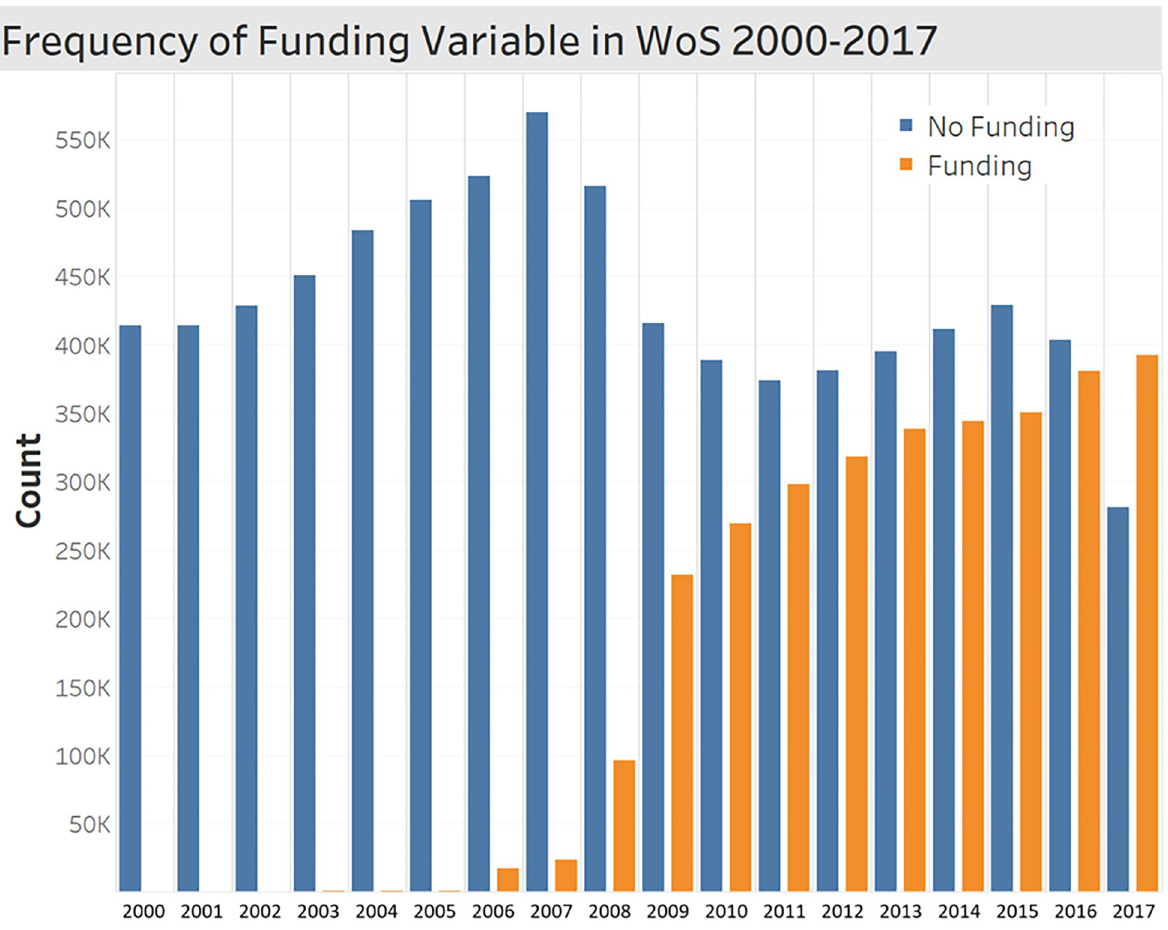
Fig 1. Frequency of funding variable in WoS